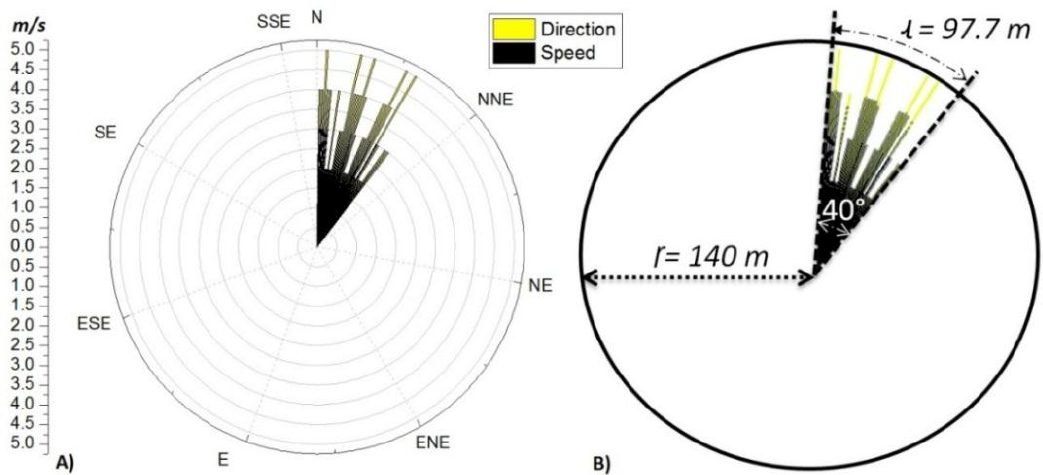
( B ) illustrate the monitored area affected by the pollutant emissions due to the wind.